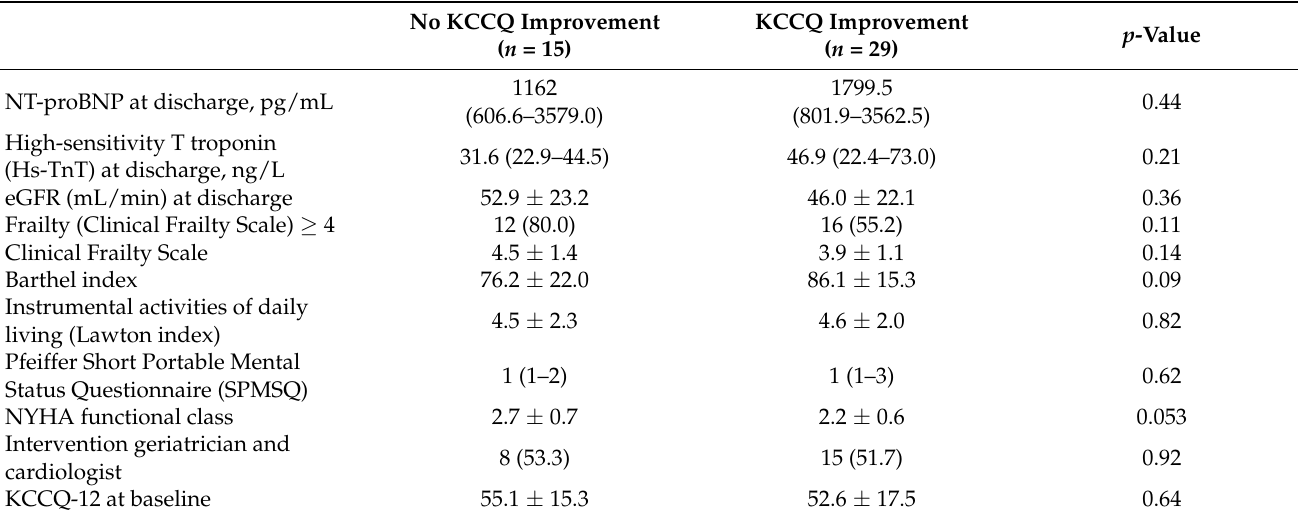
Table 5. Hospitalization and first appointment characteristics according to the improvement of KCCQ-12 at one-year